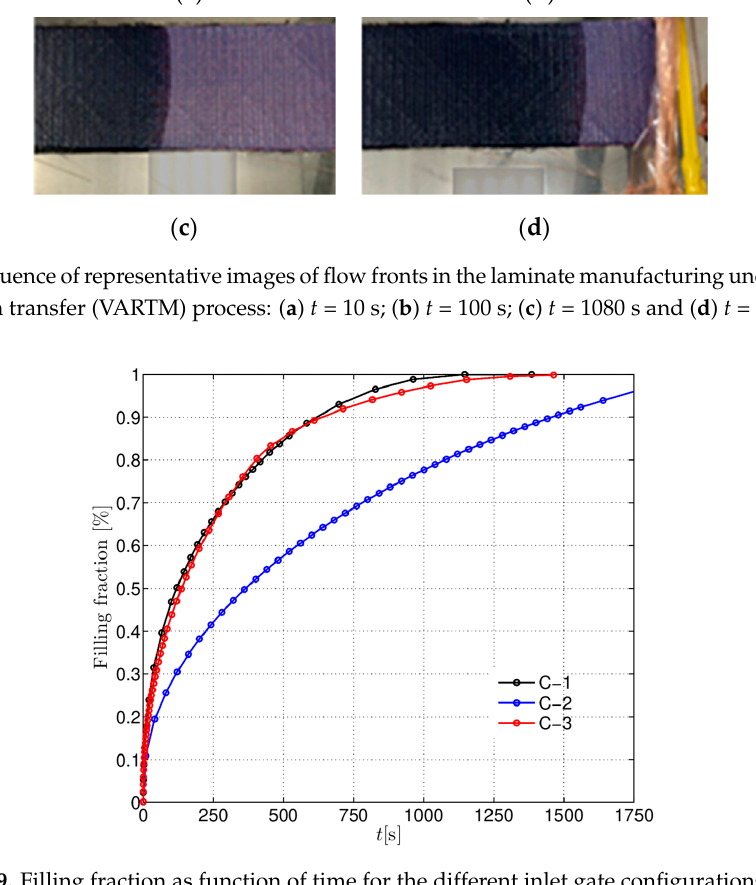
Figure 9. Filling fraction as function of time for the different inlet gate configurations gate.